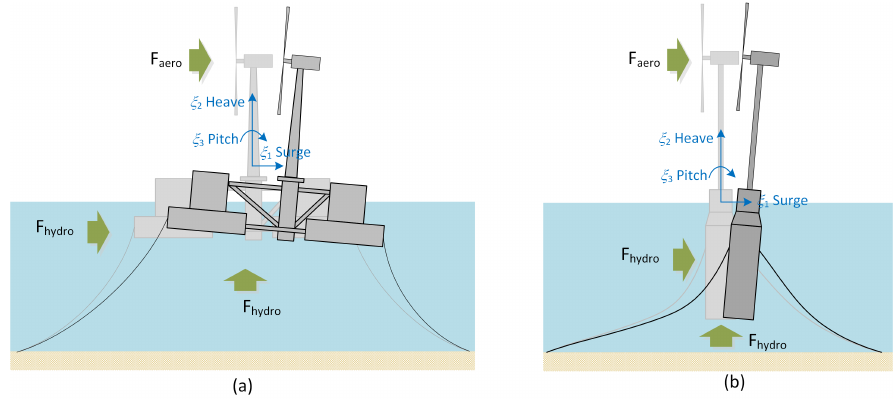
Figure 4. Movement of floating wind turbines under wind and wave conditions: ( a ) Semi- submersible; ( b )